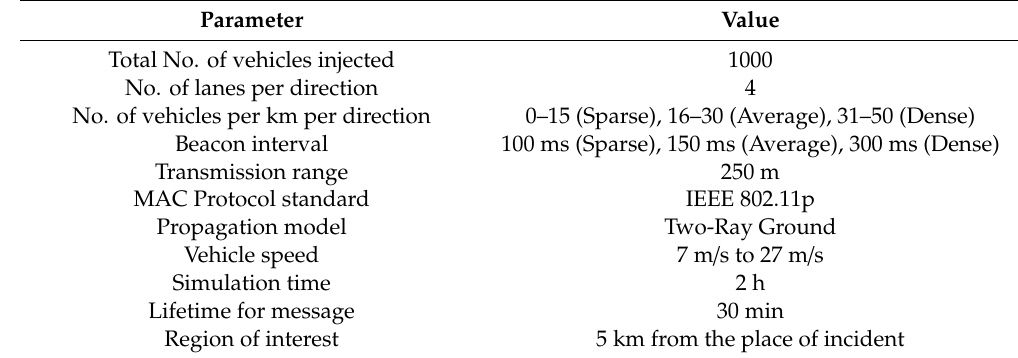
Table 3. Simulation